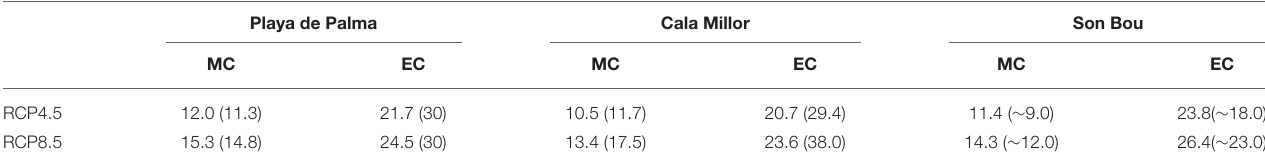
TABLE 2 | Coastline retreat (in metres) under Mean Conditions (MC) and Extreme Conditions (EC), for Playa de Palma Beach, Cala Millor and Son Bou and under the RCP4.5 and RCP 8.5 scenarios. Playa de